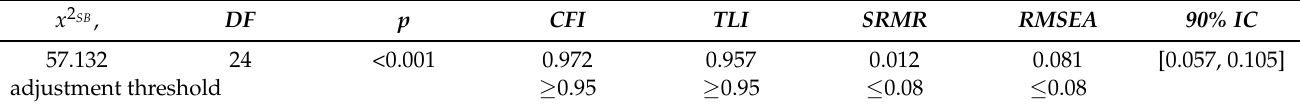
Table 5. Fit statistics for the structural